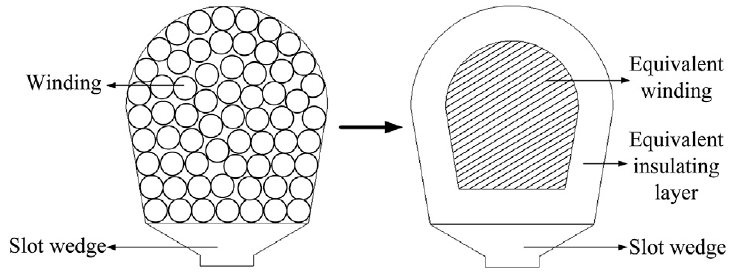
Figure 3. The sketch map of the equivalent stator slots.